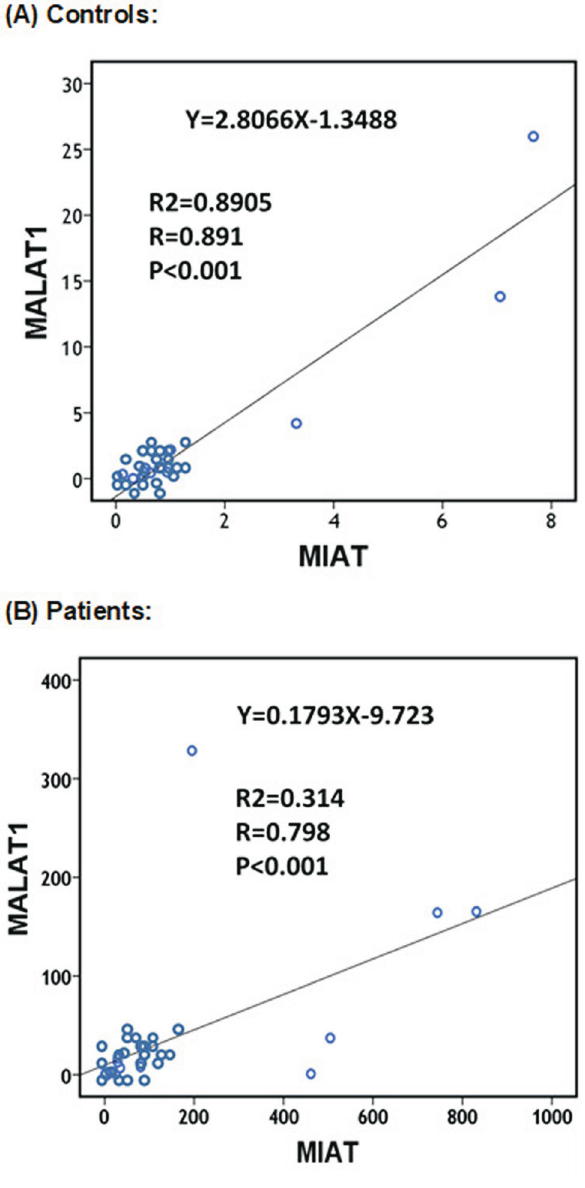
Figure 2 - Correlation between peripheral blood MIAT and MALAT1 in controls (A) and patients (B). Spearman’s rho binary correlation analysis was